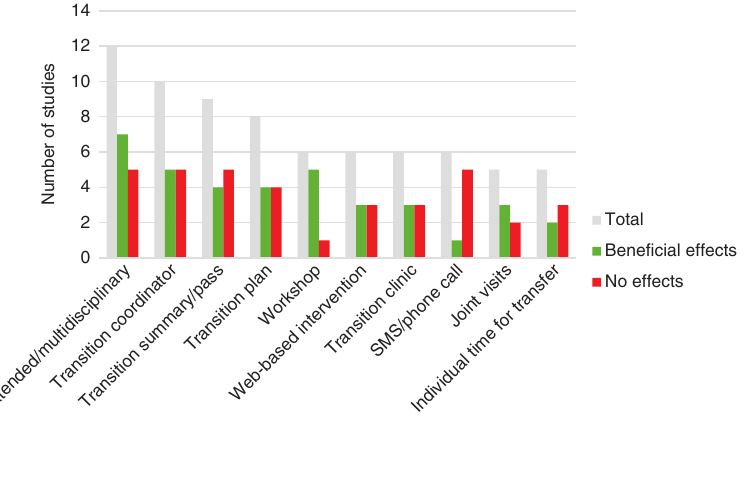
Figure 3: Number of studies that evaluated certain intervention components. Total: Total number of studies. Beneficial effects: Number of studies showing a significantly better outcome in the intervention group or in measurements after intervention compared to the control group or measurements before intervention. No effects: Number of studies showing no significant differences between groups or between measurements before and after